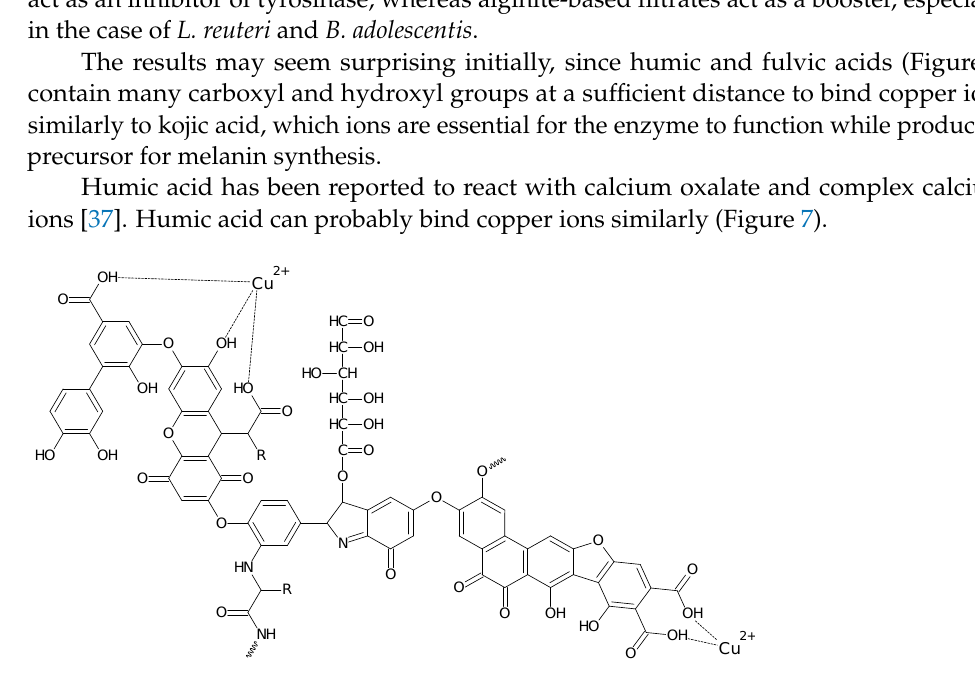
Figure 7. Illustration of the humous acid’s interaction with copper ions using the structural fragment of humous acid.